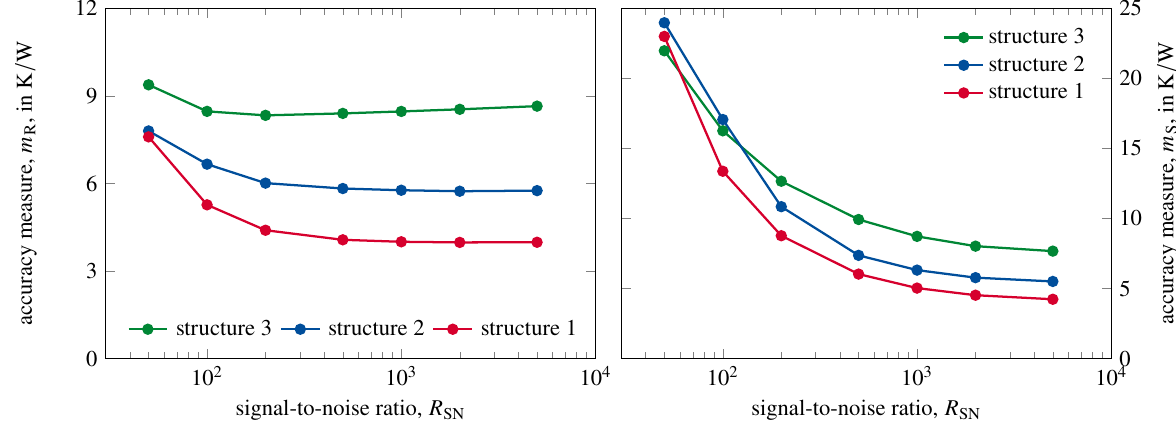
Figure 7. Accuracy of the median integrated time constant spectrum and median structure function calculated via Bayesian deconvolution for the three test structures as a function of the signal-to-noise ratio from 2000 noise